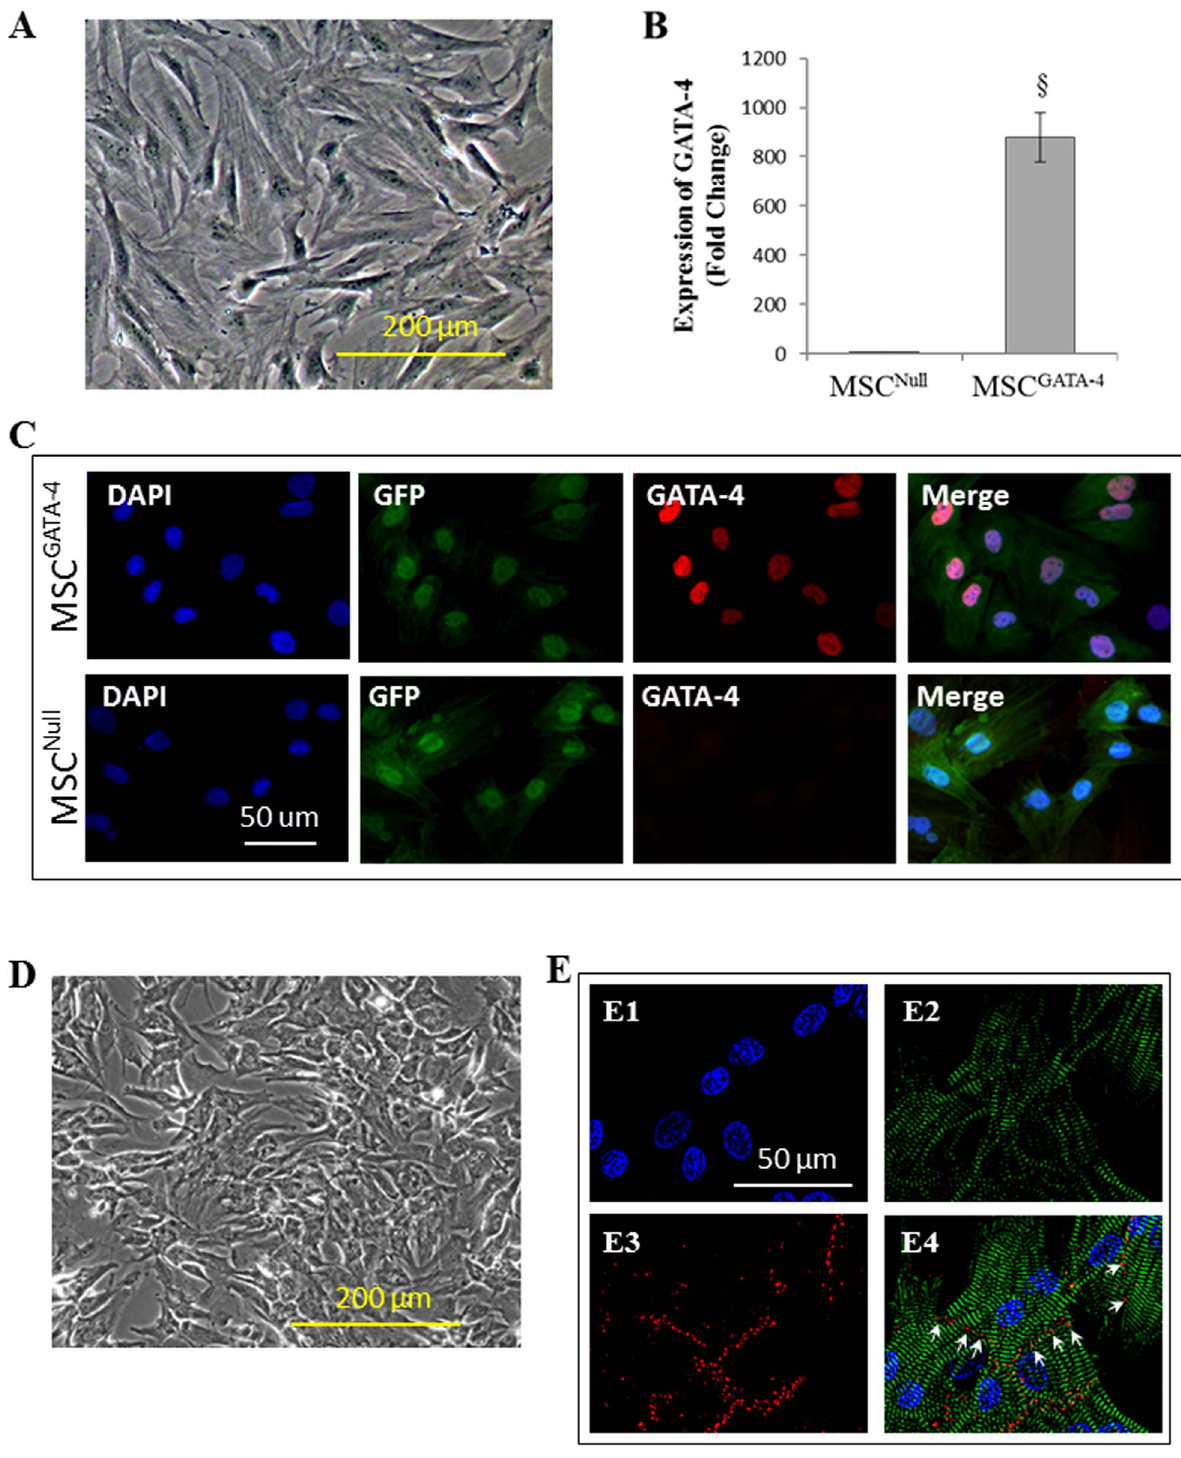
Figure 1. Morphology of cultured MSC and CM. Panel A: MSC obtained from rat bone marrow. Panel B: Quantitative real-time PCR of GATA-4 expression in MSC transduced with GATA-4 (MSC GATA-4 ) or empty vector (MSC Null ). Panel C: Immunostaining of MSC GATA-4 and MSC Null . Panel D: CM obtained from rat neonatal ventricles. Panel E: CM were immunostained positive for a -actinin (green) and connexin 43 (red, white arrows). Myofibers were seen with clear Z-lines in sarcomeres. E1: DAPI; E2: a -actinin; E3: connexin 43; and E4: merged images of E1 to E3. 1 , p , 0.05 vs MSC Null .